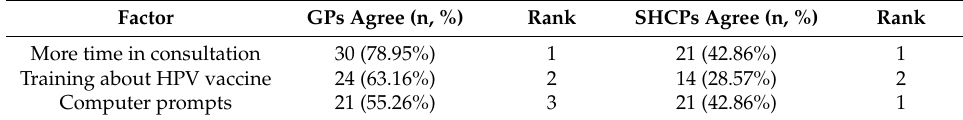
Table 5. Most frequently ranked factors supporting GPs and SHCPs vaccinating YMSM against HPV. Factor GPs Agree (n, %) Rank SHCPs Agree (n, %) Rank More time in consultation 30 (78.95%) 1 21 (42.86%) 24